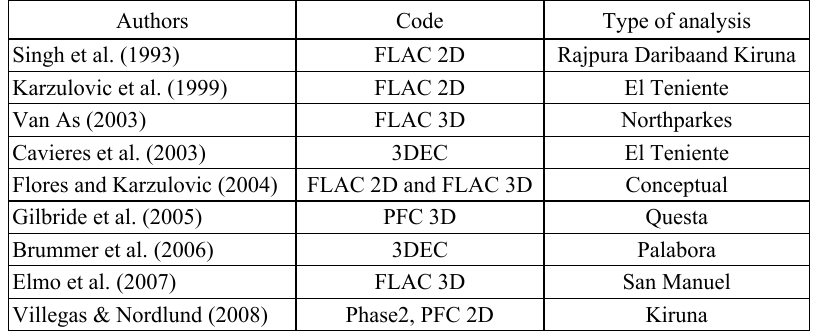
Table 2. Numerical studies of caving-induced surface subsidence (Vyazmensky [28])